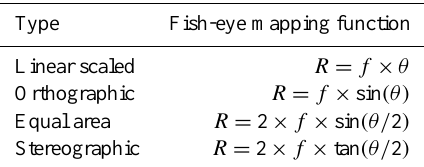
Table 3. Fish-eye mapping functions. F is the effective focal length of the lens, and θ is the angle to the optical axis.